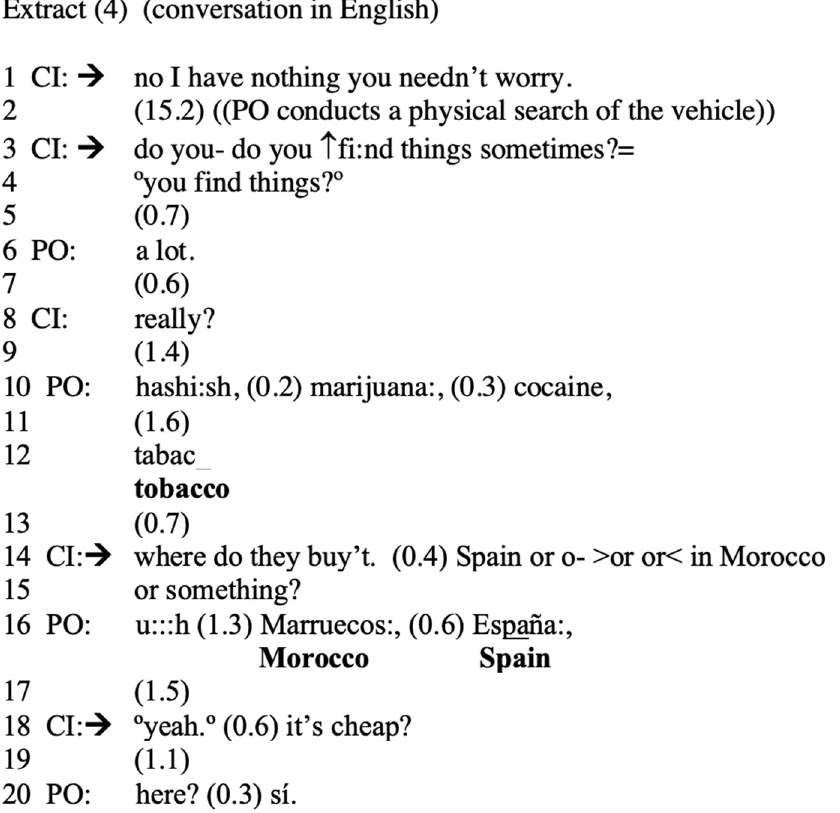
Figure 7. Extract (4).